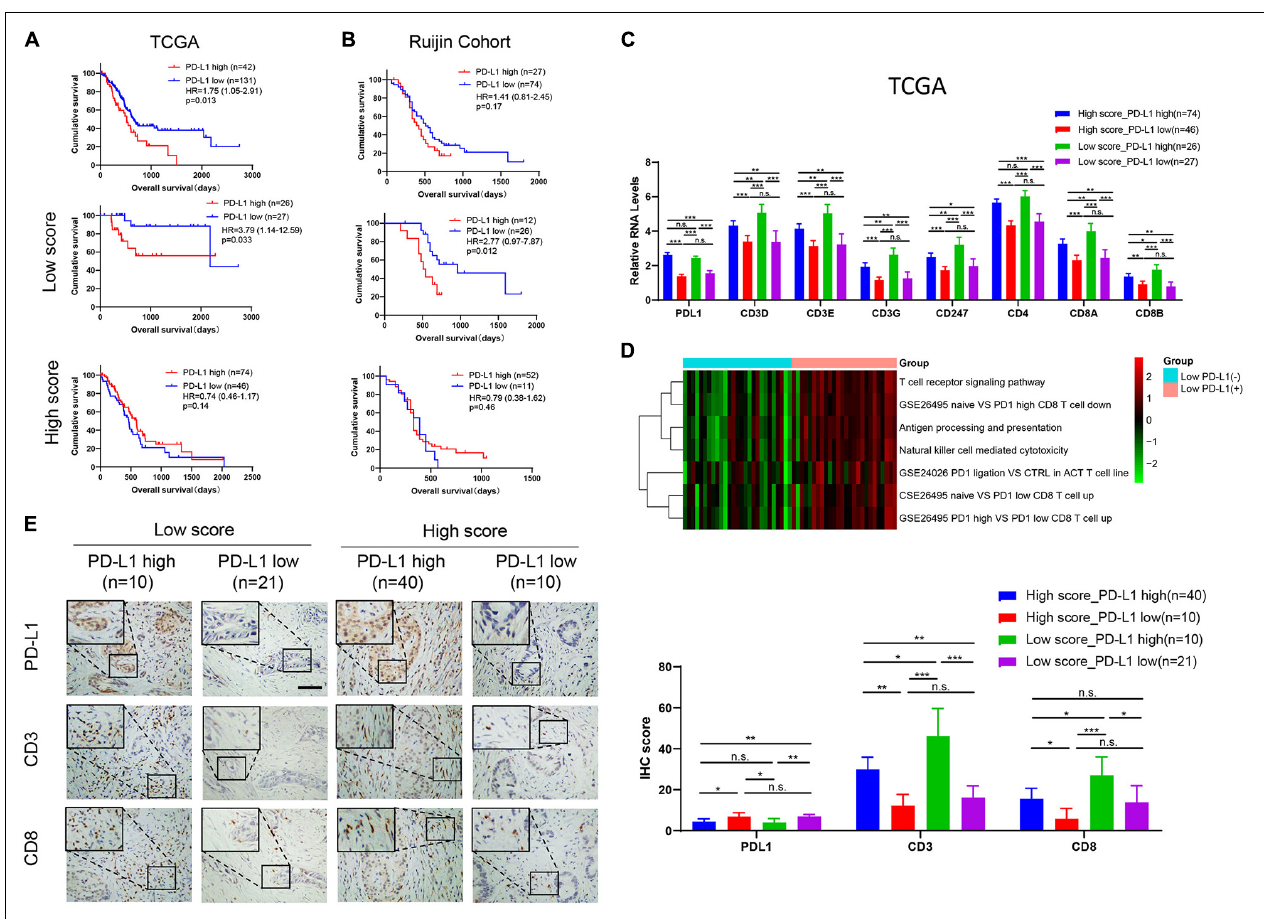
FIGURE 8 | PD-L1(+) cases in low score group show inferior prognosis and lymphocytes infiltration. Kaplan-Meier survival curves of PD-L1 expression in all patients, the low score group, and the high score group in (A) TCGA (High score: PD-L1 high, n = 74; PD-L1 low, n = 46. Low score: PD-L1 high, n = 26; PD-L1 low, n = 27) and (B) Ruijin cohort (High score: PD-L1 high, n = 52; PD-L1 low, n = 11. Low score: PD-L1 high, n = 12; PD-L1 low, n = 26). (C) The relative RNA level of immune infiltration markers in the TCGA database, including PD-L1, CD3D, CD3E, CD3G, CD247, CD4, CD8A, CD8B. (D) Heatmap showed that higher GSVA scores of T cell immunoreaction pathways and PD1-related immunosuppressive pathways in PD-L1(+) than in PD-L1(–) cases in low score group. (E) IHC profile and corresponding scores of PD-L1, CD3 and CD8 in four groups (High score_PD-L1 high, n = 40; High score_PD-L1 low, n = 10; Low score_PD-L1 high, n = 10; Low score_PD-L1 high, n = 21). * p < 0.05; ** p < 0.01; *** p < 0.001; n.s., p >